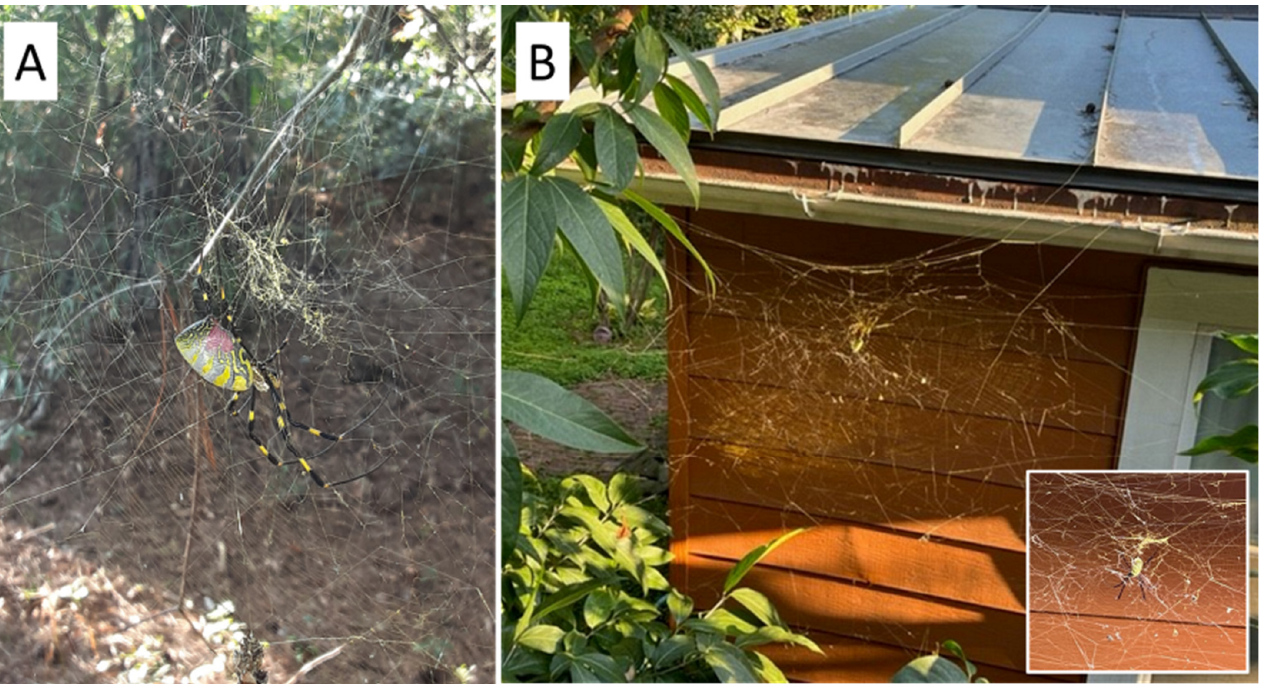
Figure 1. ( A ) A female jor ō spider, Trichnephila clavata , in its web. Note the complex (not two-dimensional) web pattern. Photo taken by A. Davis in Watkinsville, GA on 18 October 2020. ( B ) Photograph of the jor ō spider web in Atlanta where the observation occurred. The web was strung between stalks of wintersweet and a neighboring structure and was approximately 1.25 m × 1.25 m in size.